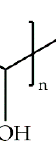
Figure 19. Molecular structure of poly(vinyl alcohol) (PVA).